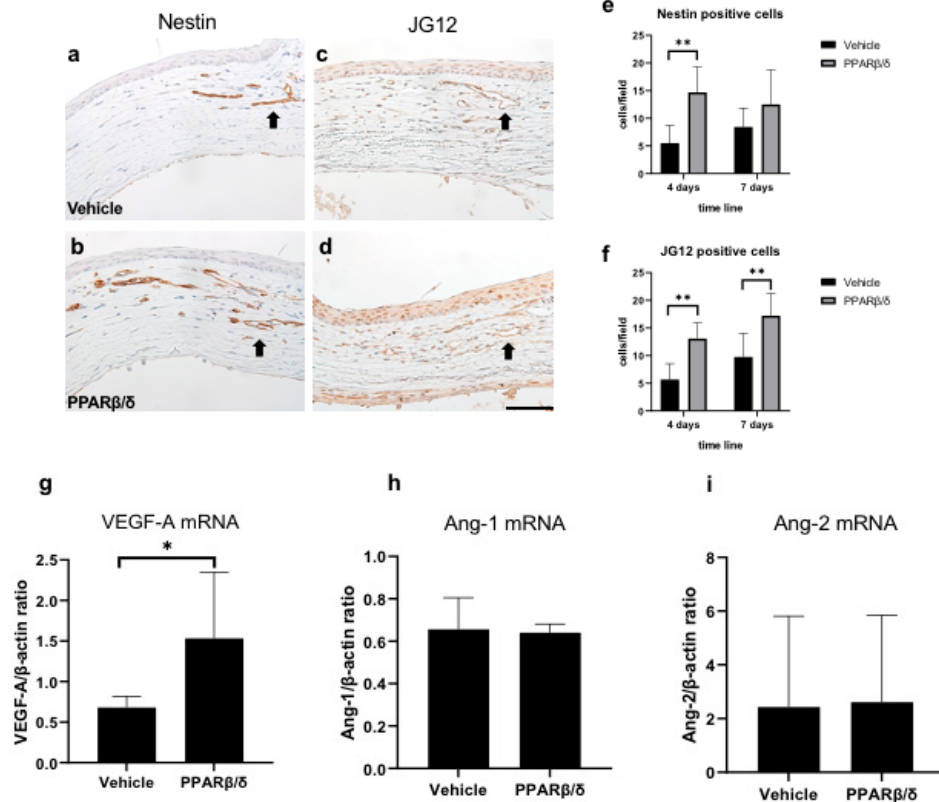
Figure 7. Evaluation of neovascularization. Nestin immunostaining in the corneal limbus on day 4 ( a : vehicle group, b : PPAR β / δ group). JG12 immunostaining in the corneal limbus on day 7 ( c : vehicle group, d : PPAR β / δ group). Black arrows: immunopositive cells. Bar, 50 μ m. Nestin-positive endothelial cells, and JG12-positive capillary lumens were observed from day 4. The number of nestin-positive cells was higher on day 4 in the PPAR β / δ group compared to the vehicle group ( e ). The number of JG12-positive cells was higher on days 4 and 7 in the PPAR β / δ group compared to the vehicle group ( f ). Among cytokines related to angiogenesis, only VEGF-A showed a significant difference between the PPAR β / δ group and vehicle group ( g–i ). Data are presented as mean ± SD ( n = 8) ** p < 0.01 or * p < 0.05.